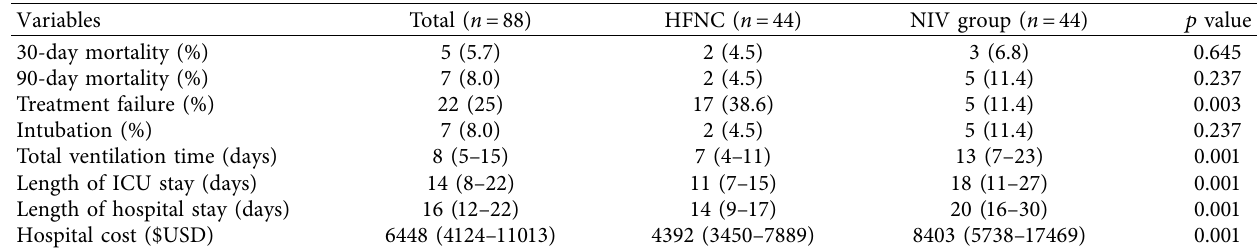
Table 4: Clinical outcomes after propensity score